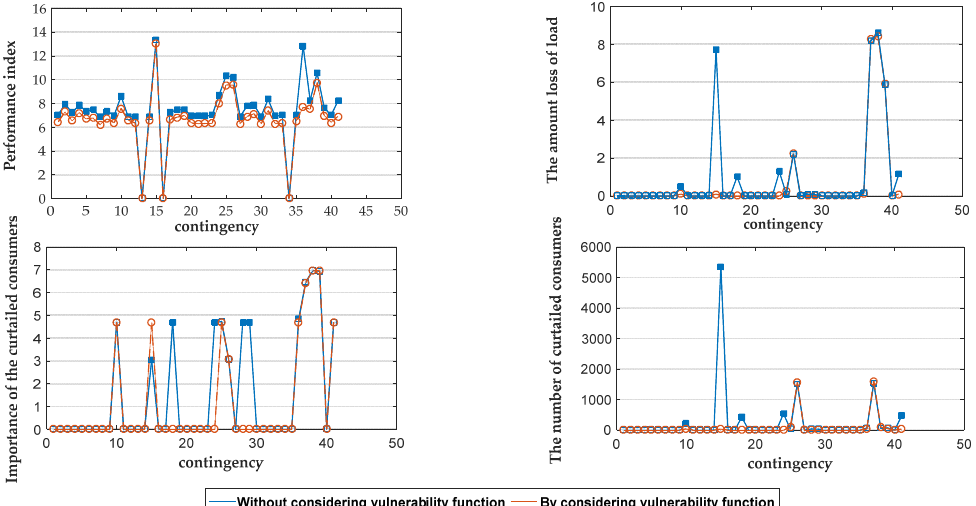
Figure 5. Resilience metrics for the final solution in Cases 1 and 3.